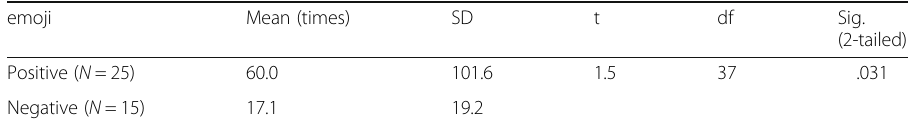
Table 6 Independent sample t-test of positive and negative emoji count emoji Mean